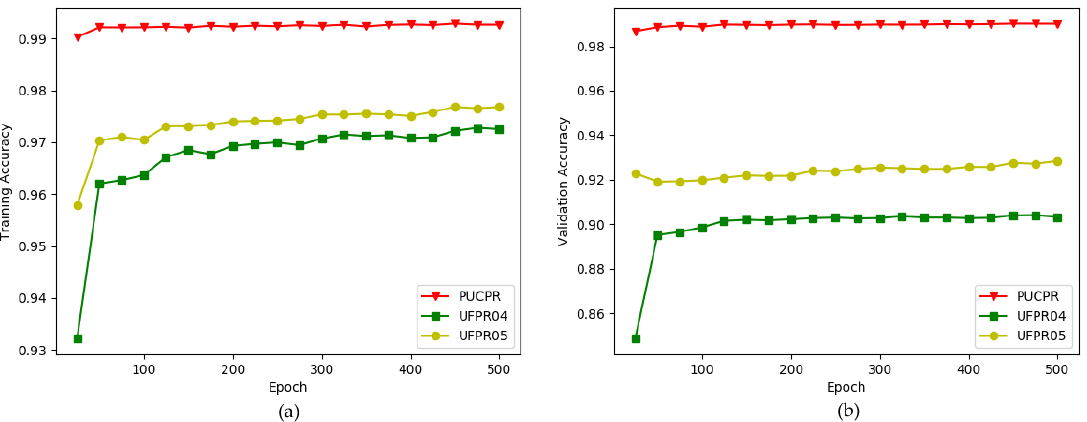
Figure 8. Comparison of subsets of PKLot dataset [4]. x-direction: number of epochs (500), y-direction: accuracy. ( a ) training accuracy; ( b ) validation accuracy.